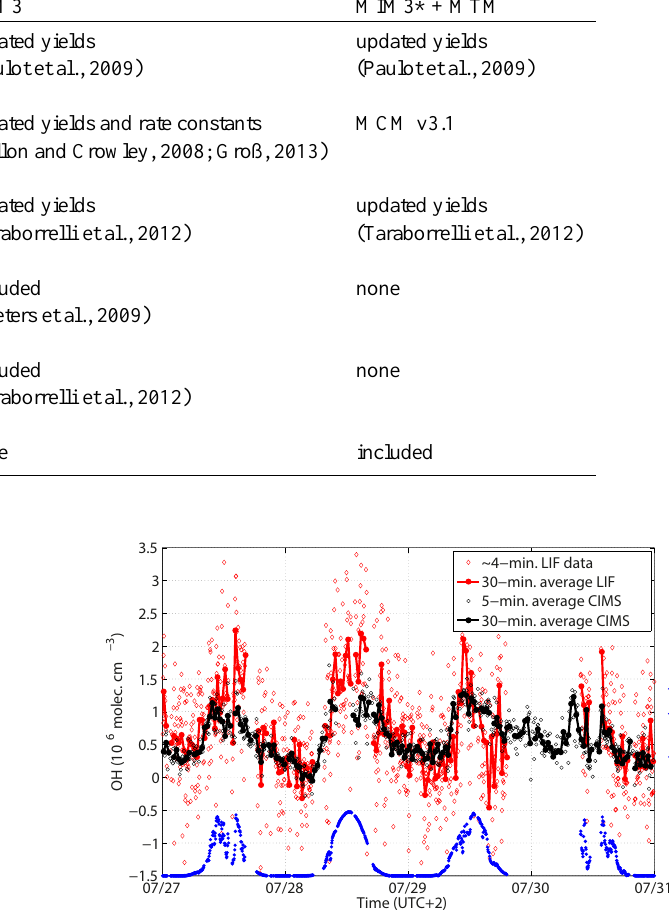
Figure 5. Comparison of OH measurements by IPI-LIF-FAGE tech- nique and by CIMS on the ground (University of Helsinki, Petäjä et al., 2009). Night-time OH was observed by both techniques. J observed on the ground is indicated in O ( 1 D )